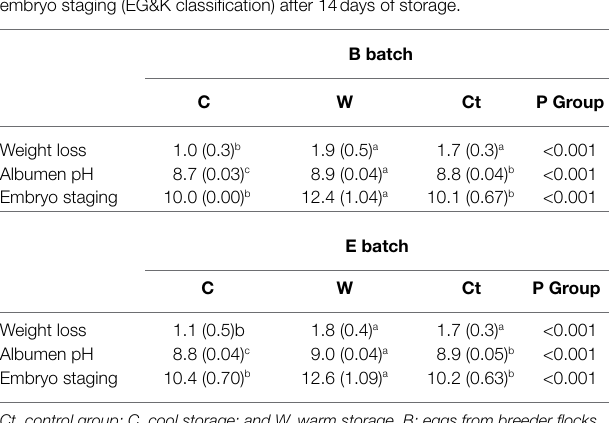
TABLE 1 | Mean (SD) of weight loss (% of initial weight), albumen pH and embryo staging (EG&K classification) after 14 days of